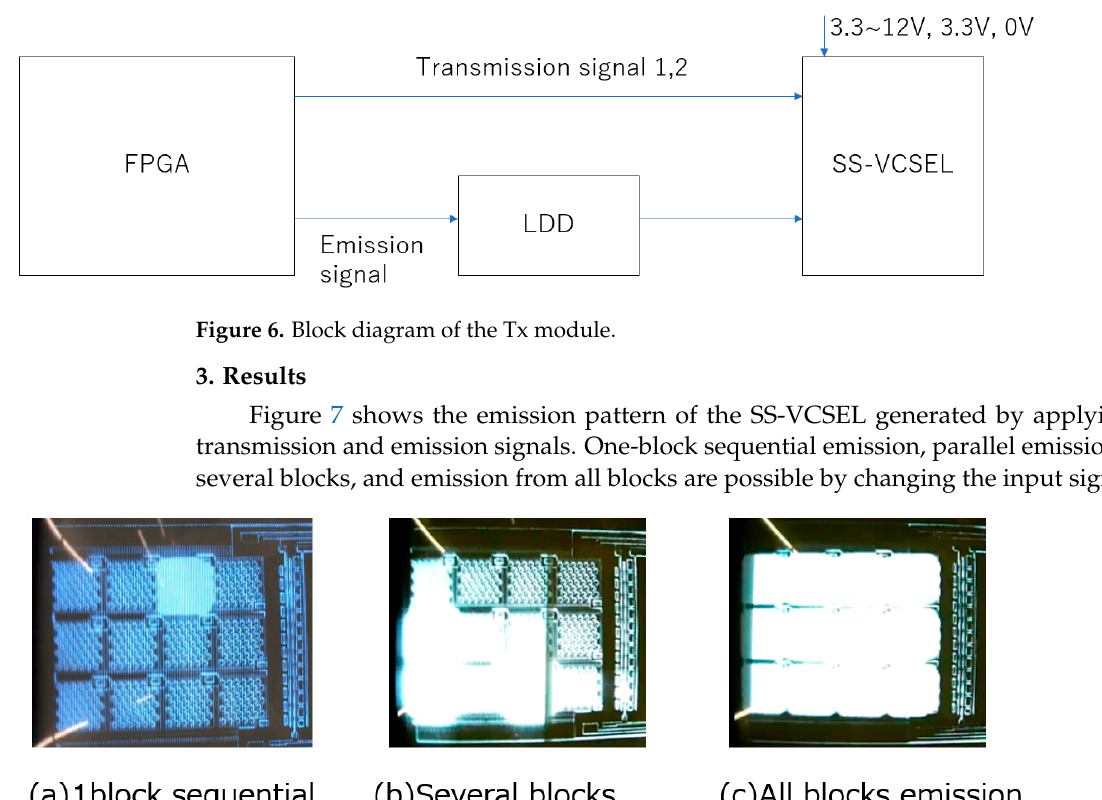
Figure 5. Top view of Tx module containing the SS-VCSEL and the optical device.